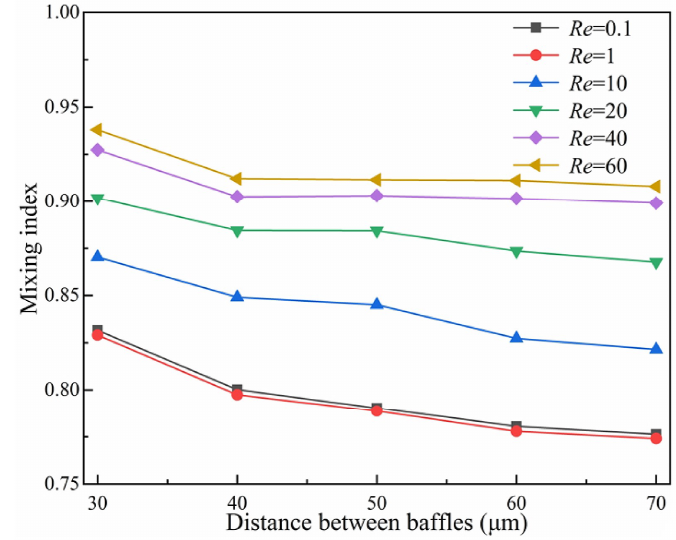
Figure 20. Effect of the distance of baffles on the mixed index.